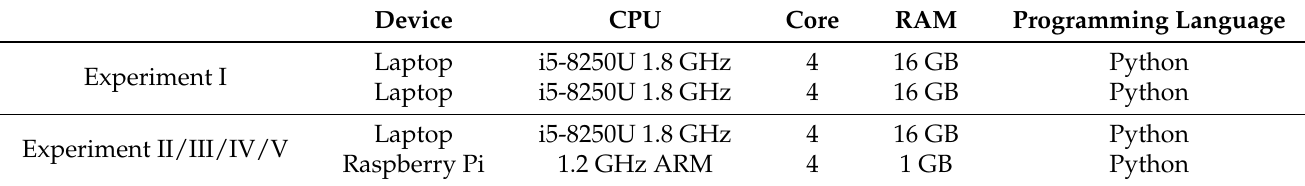
Table 8. Experiment devices and environments.